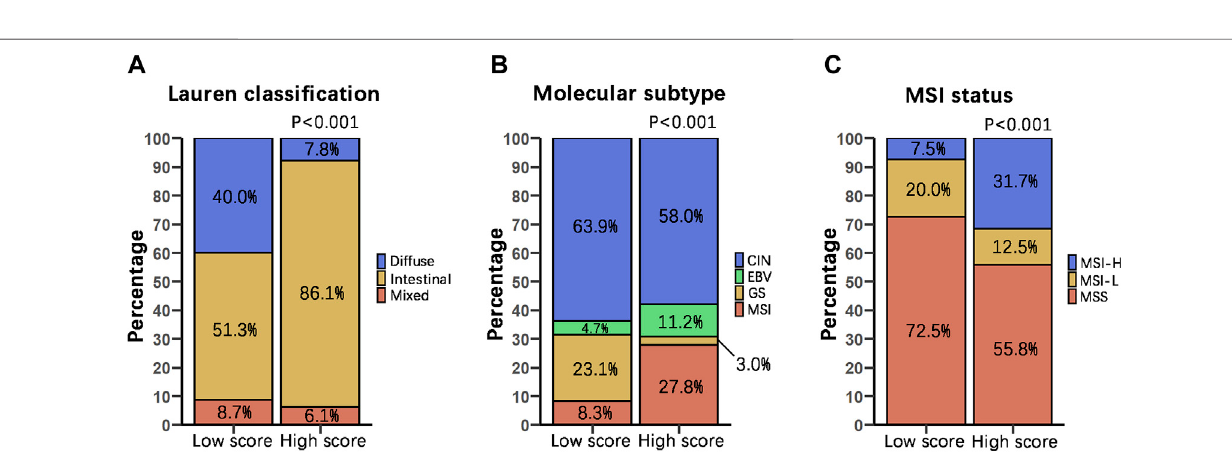
Frontiers in Cell and Developmental Biology |